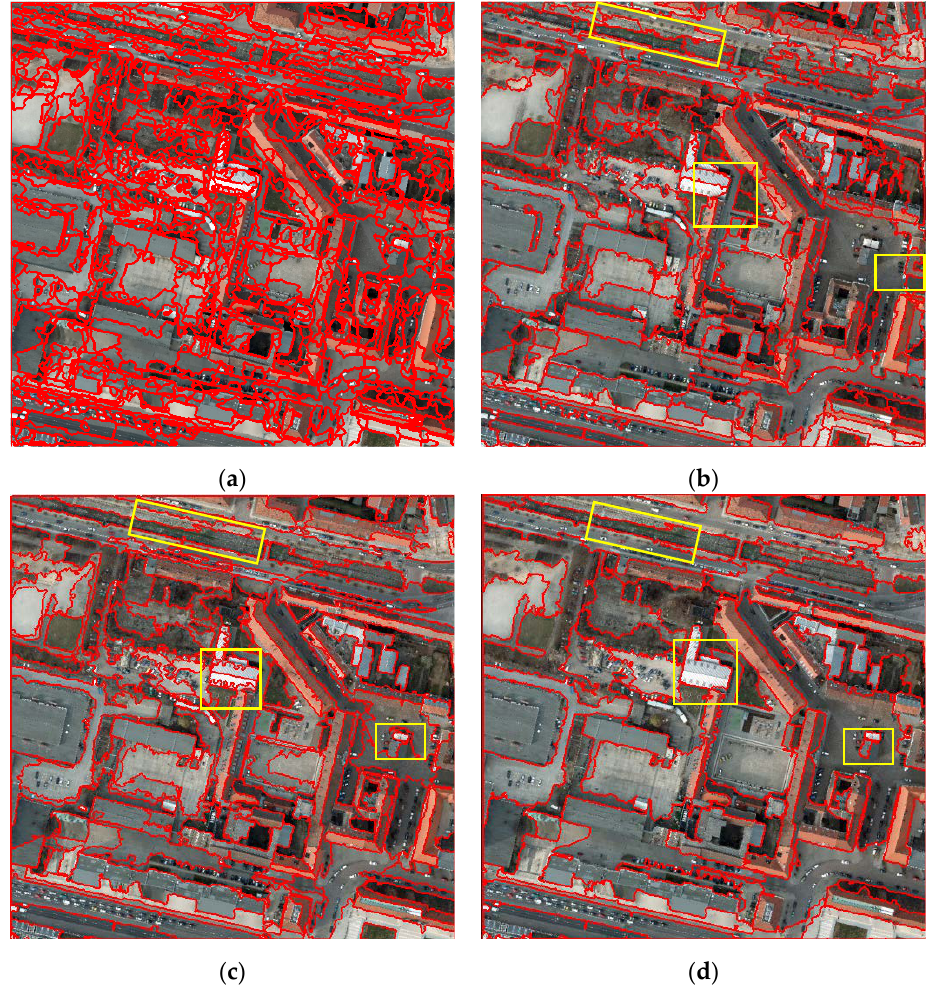
Figure 14. Segmentation results produced by different methods for the Potsdam aerial image (T6): ( a ) WTS; ( b ) MS; ( c ) MRS; ( d ) MMHS.